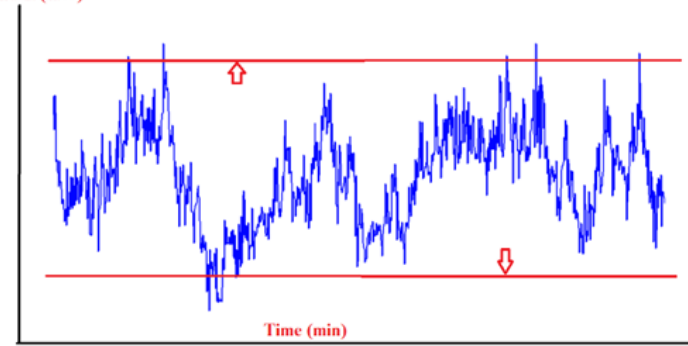
Figure 4. The background noise of heat flux.